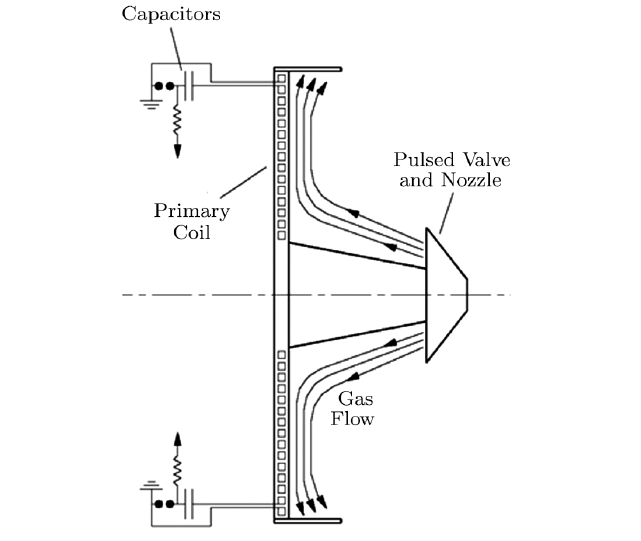
Figure 3. Schematic showing a typical propellant injection scheme employed on the PIT (from